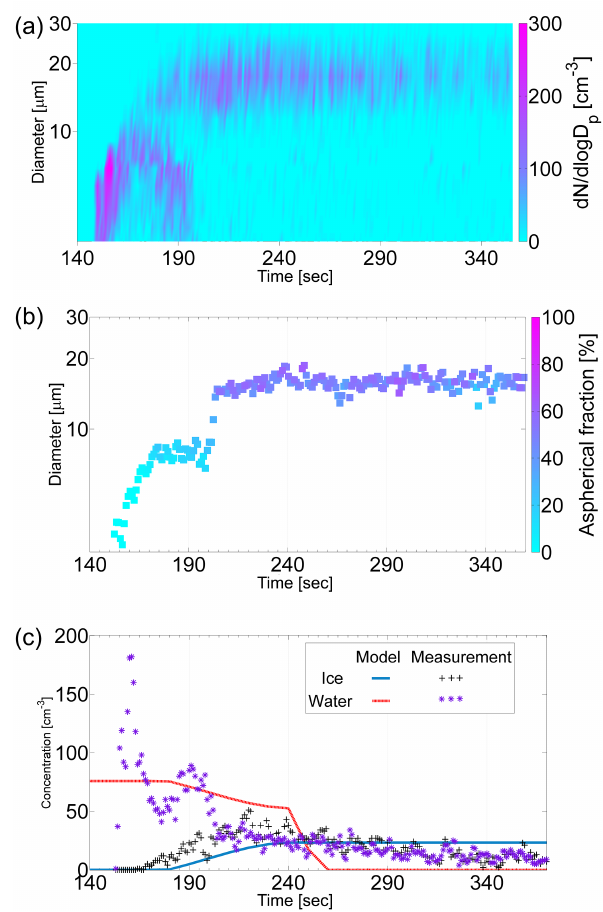
Figure 2. Mixed-phase cloud, phase transition period (Run no. 1291.16). The uncertainty in sizing is of the order of the size bin width (Table S2). The error of the polarization ratio and aspheric- ity is approximately 20%. (a) CASPOL particle-size distribution, (b) CASPOL PBP aspherical fraction, (c) CASPOL measured wa- ter and ice concentrations derived from asphericity compared to